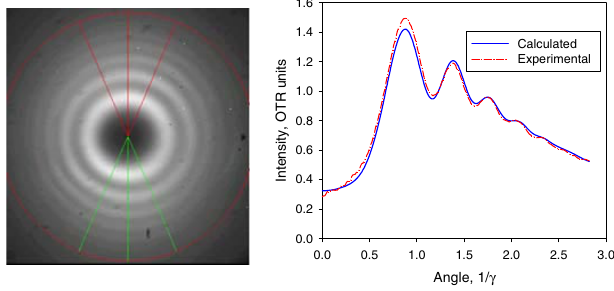
FIG. 13. (Color) ODTR (left) and OTR (right) interference patterns at an x waist condition; overlay: sectors of the angular regions over which the intensity is averaged to produce an x line scan.